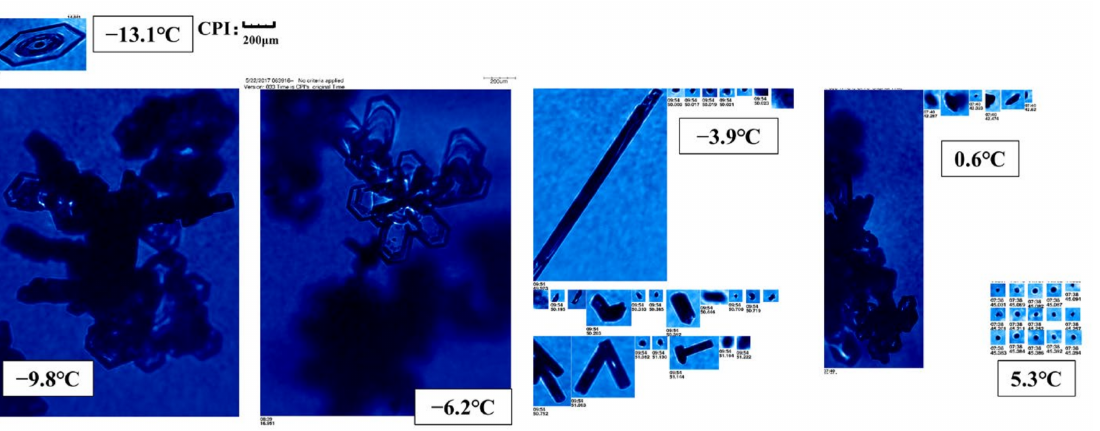
Figure 11. Particles image of the flight on 22 May 2017. On 21 May 2018, aggregates formed by collision and riming of ice particles were observed in the negative temperature layer close to the 0 ◦ C layer. There were large drops below the 0 ◦ C layer. At the V2 detection stage, it was found that the ice phase particles at the same temperature had different shapes, while at different heights. At the same temperature ( − 1.6 ◦ C), the particles at the height of 4975 m were dominated with aggregates of columns, co-exited with riming process, while most of the particles at 4583 m were already melted based on their regular edge. In the negative temperature layer close to the 0 ◦ C layer, as the particles began to melt, absorbing latent heat, so an isothermal layer was formed near the 0 ◦ C layer (Figure 12).